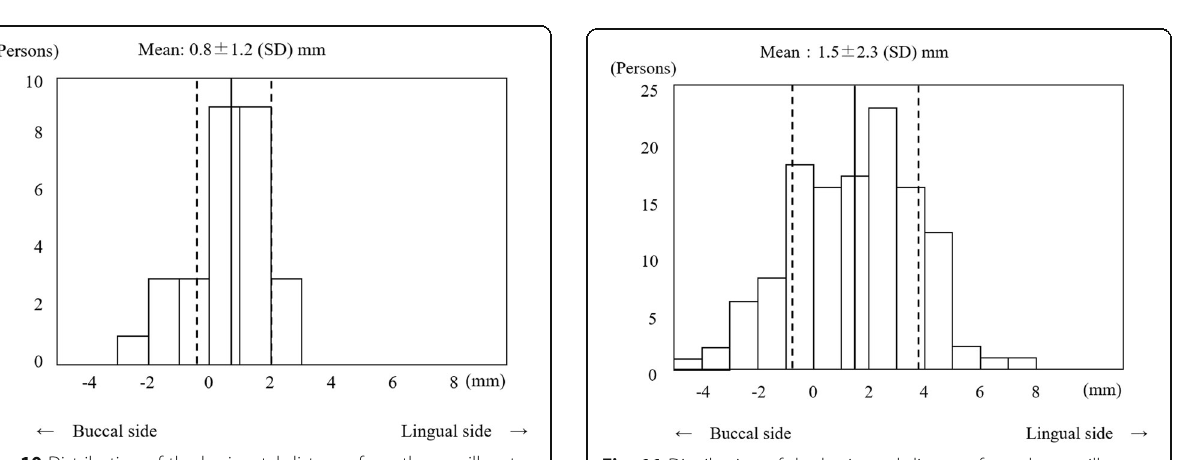
Fig. 11 Distribution of the horizontal distance from the maxillary first molar to the mandibular residual ridge (A – B) ( n =